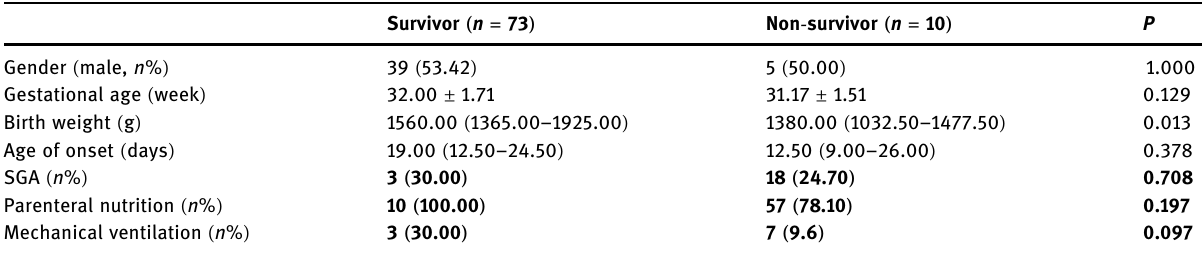
Table 2: Baseline clinical characteristics of the survivor and the non - survivor groups Survivor ( n = 73 )